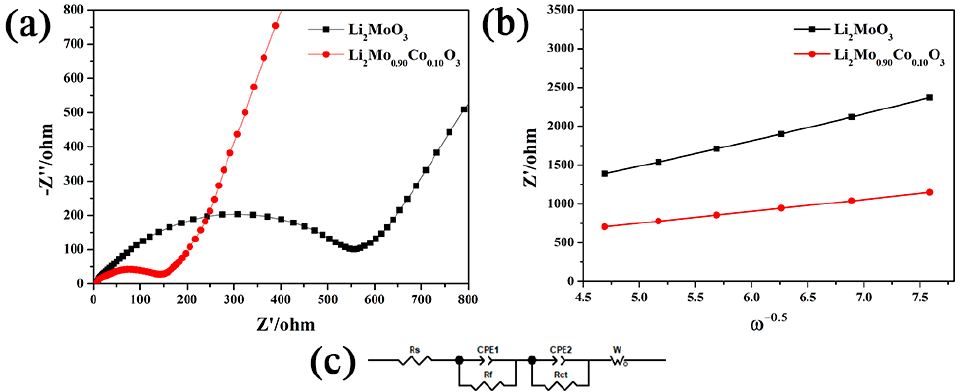
Figure 10. ( a ) EIS plots of Li 2 MoO 3 and Li 2 Mo 0.90 Co 0.10 O 3 after 20 cycles between 1.5 and 4.5 V at 5